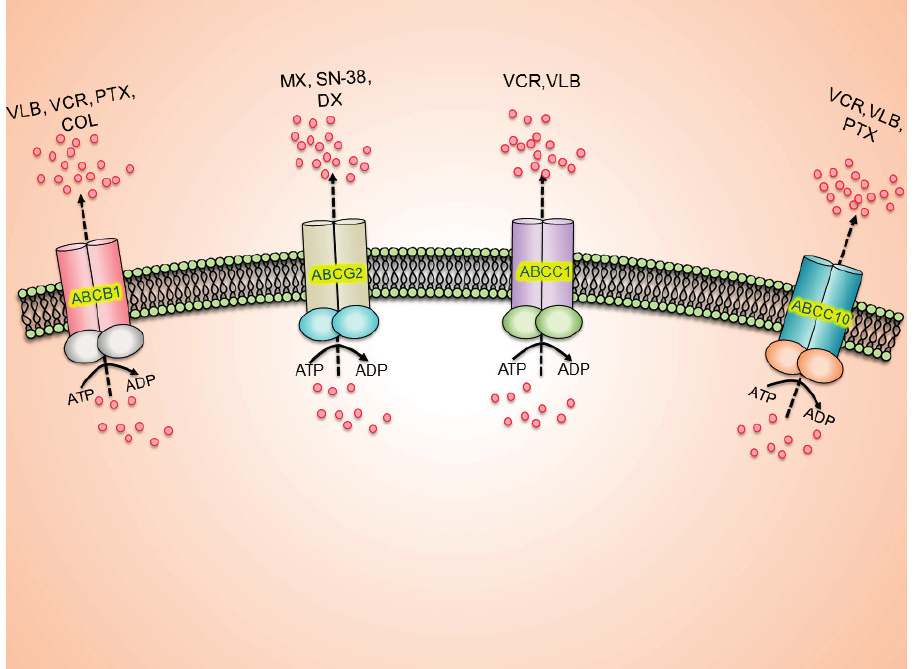
Figure 1. ABC drug transporter-mediated multi drug resistance